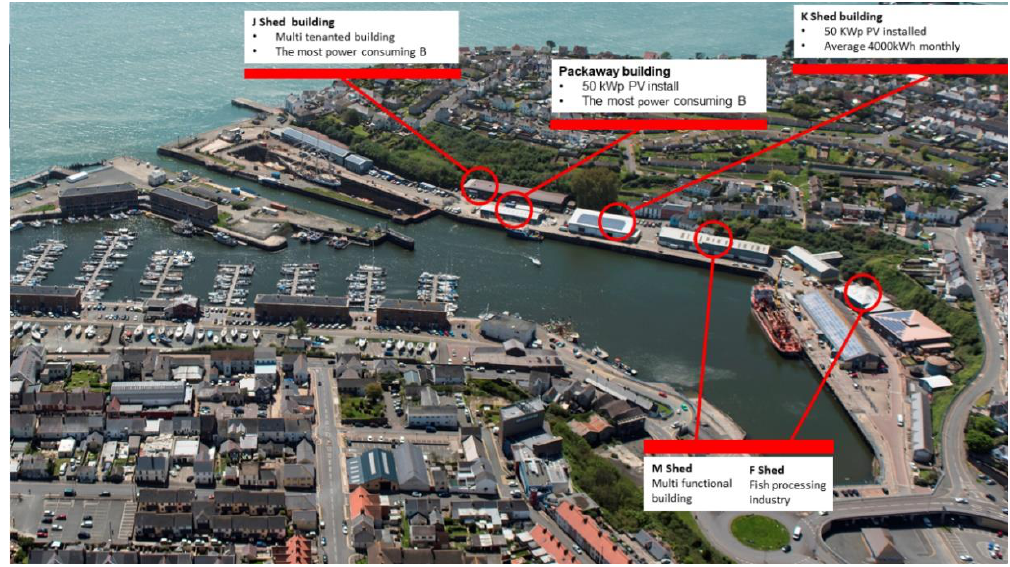
Figure 1. Fish processing industries in Milford Haven port with the solar farm.